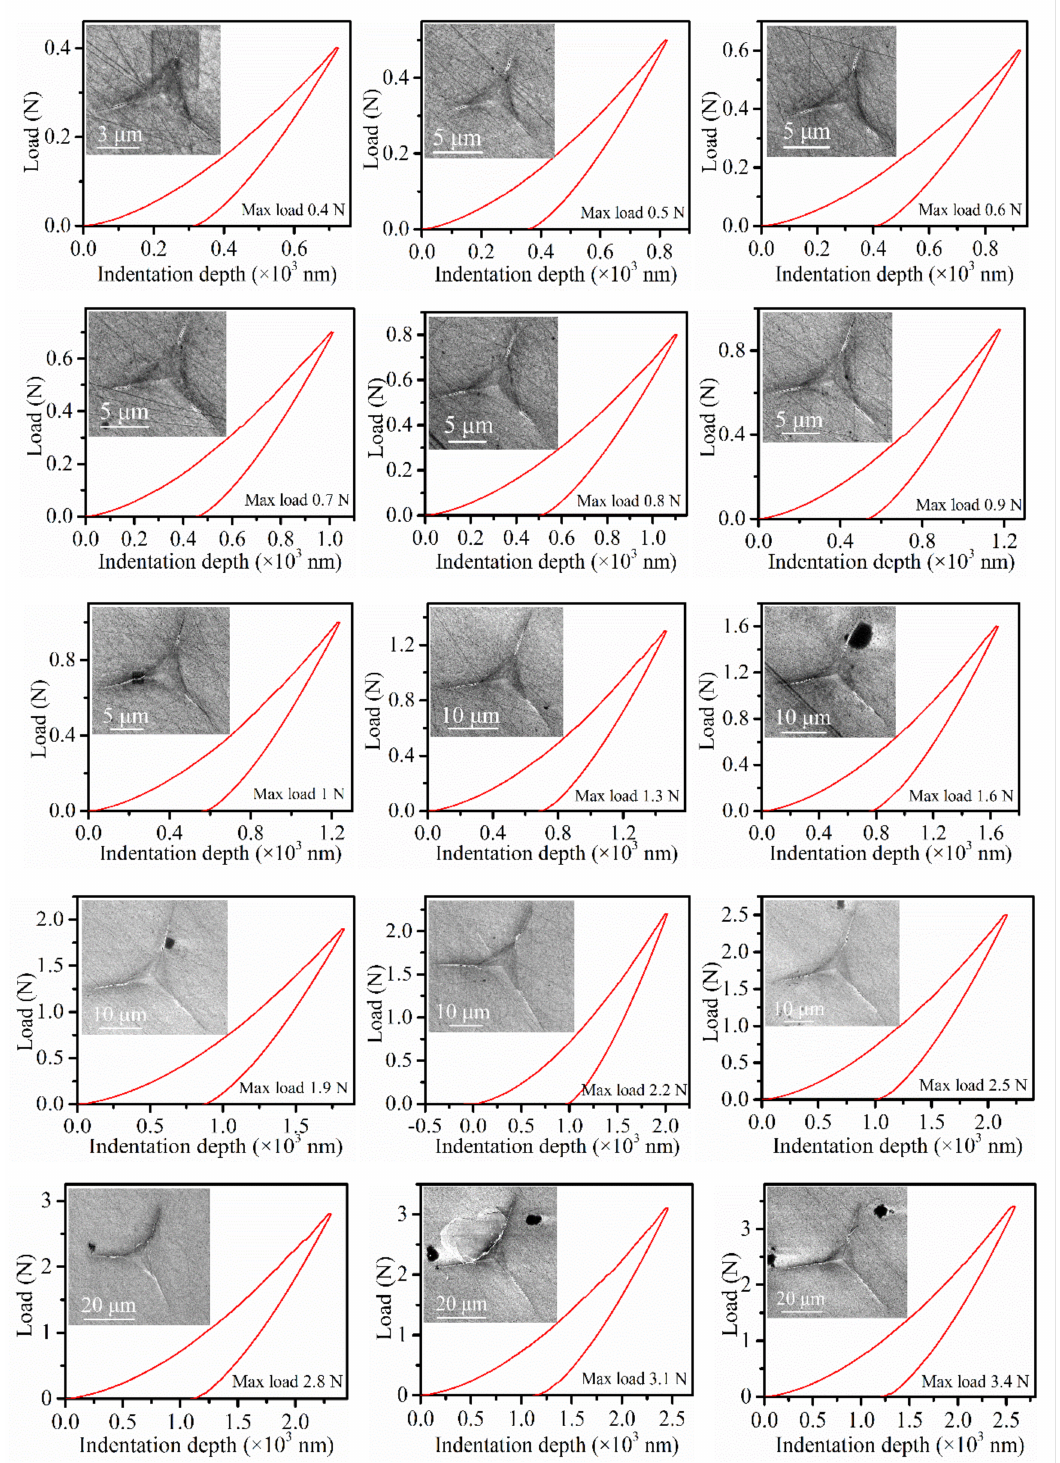
Figure 7. Di ff erent loads vs. indentation depth curves and corresponding SEM